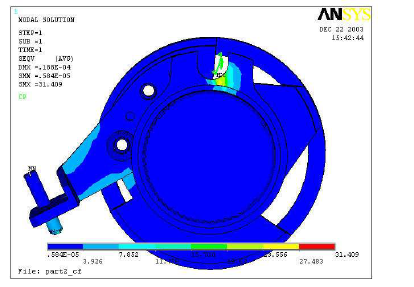
Fig. 14. Strength Analysis of Subassembly